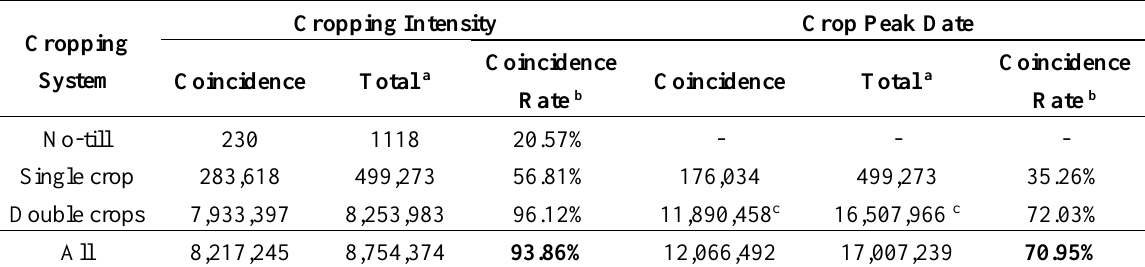
Table 2. The statistics of comparisons in the results of cropping intensity and crop peak dates based on two HTSNs synthesized by two different schemes. The numbers in the table indicate the number of 30 m